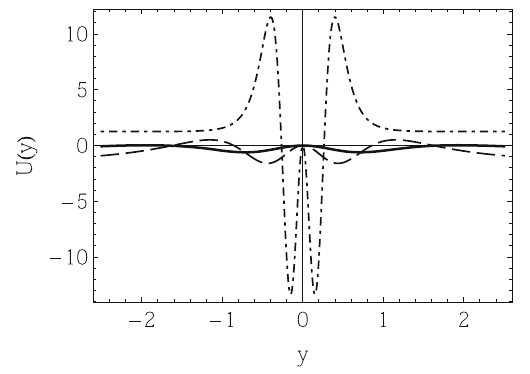
Fig. 16 Numericalplotof U ( y ) for U ( 0 ) = 0, ψ 0 = 1,and ϕ 0 = 1 . 47, with λ = 0 (solid line), λ = 0 . 4 (dashed line), and λ = 0 . 8 (dot-dashed line)